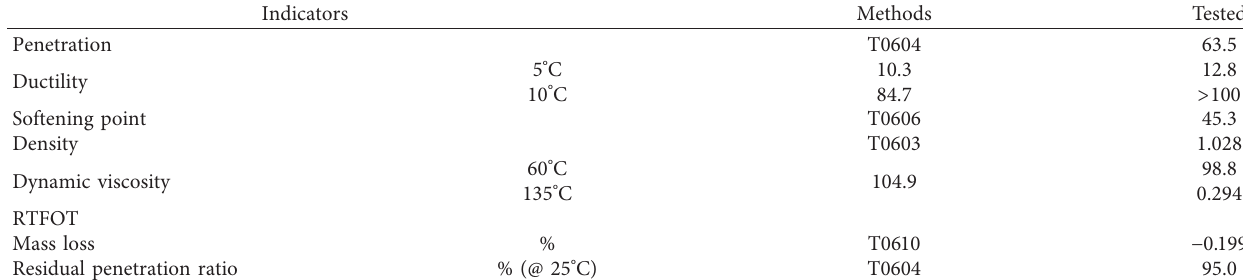
2 /CaCO 3 -modified